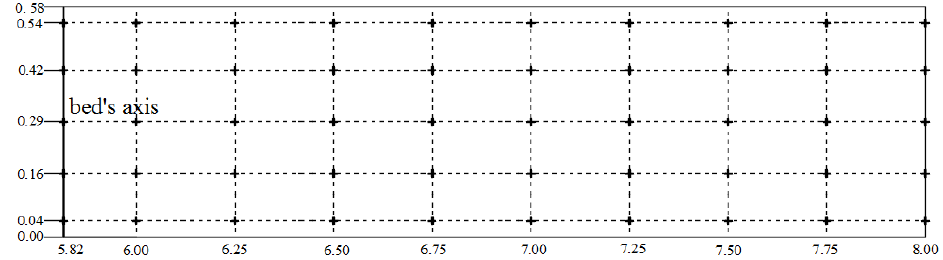
Figure 5. Probing points in the area of sandy bed—plan view; all dimensions in meters; “+”—bed probing points.